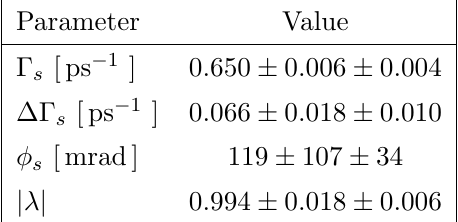
Table 2 . Fit results for the B 0